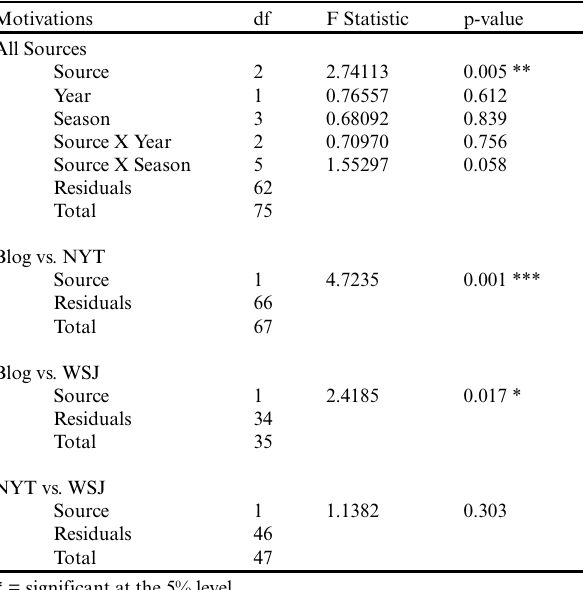
Fig. 4 . Motivation category box plots, see Figure 2 for codes contained within each category.